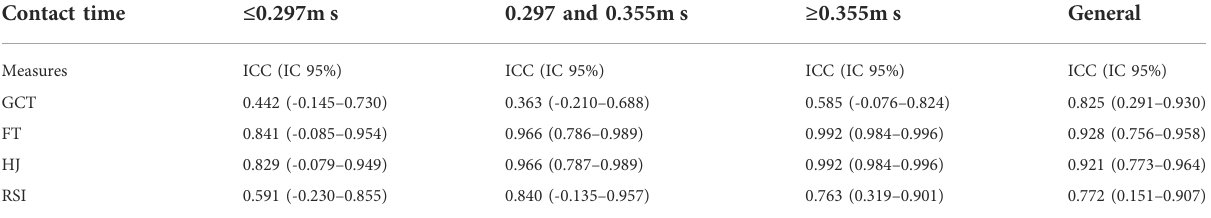
TABLE 3 Intraclass correlation coef fi cients and 95% con fi dence intervals for measures reported by the Output Sport device. Contact time ≤ 0.297m s 0.297 and 0.355m s ≥ 0.355m s